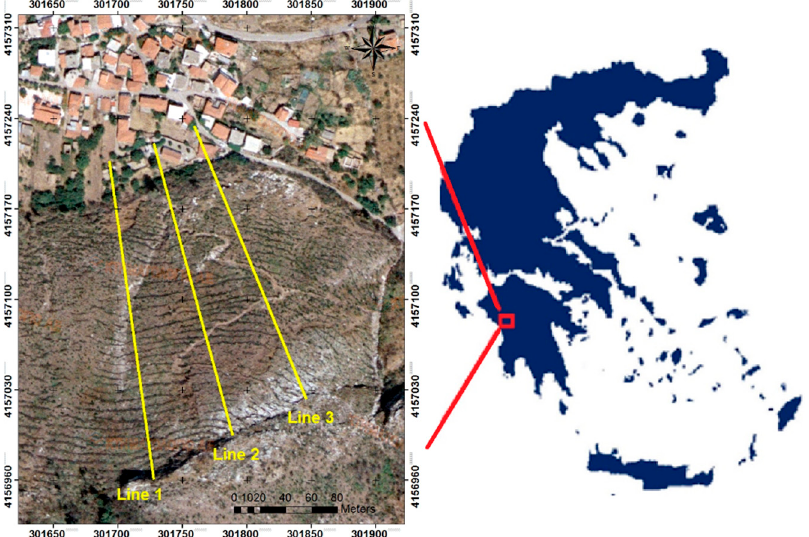
Figure 7. Slope profiles used RocFall analysis regarding Platiana region. The slope picture is taken from Greek Cadastral (2008). Table 4. Geological and material characteristics.